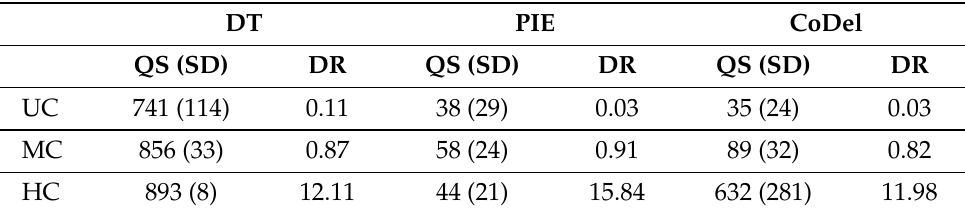
Table 13. Mean queue length (QS) and standard deviation (SD) of queue length [pkts] and packet drop ratio (DR) [%] in the Access Link scenario with mixed TCPs, UC—uncongested, MC—mildly congested, HC—heavily congested